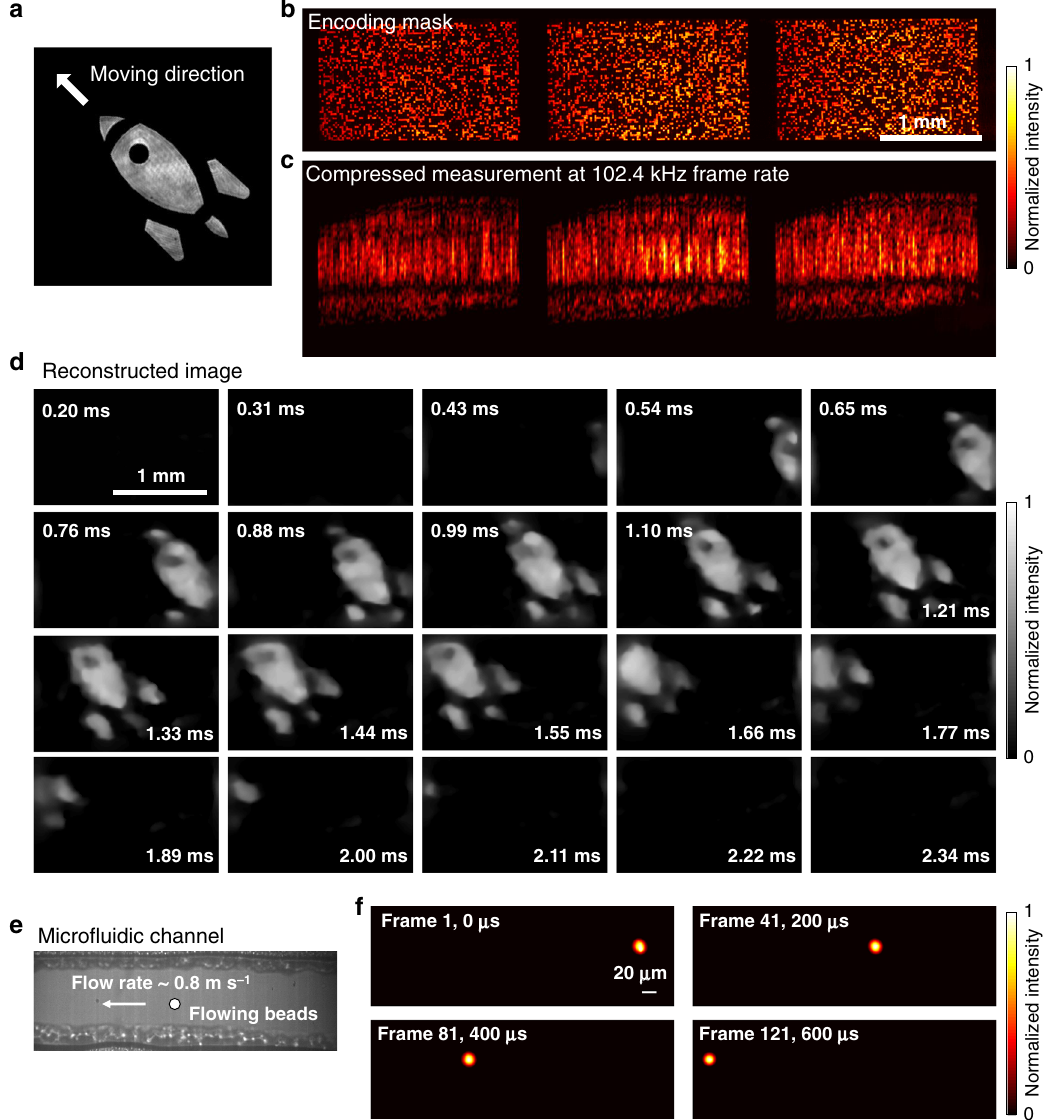
Fig. 6 ( x , y , t ) imaging through compressed optical mapping. a Target object. Three complementary masks ( b ) encode a dynamic scene. The scene was compressed and integrated into 1D line data by the TDI operation and continuously streamed to a host computer ( c ). d Computational reconstruction of the scene. The scene was captured at 102.4 kHz. e Photograph of a micro fl uidic channel. f Representative temporal frames of a fl owing fl uorescent bead imaged at 200